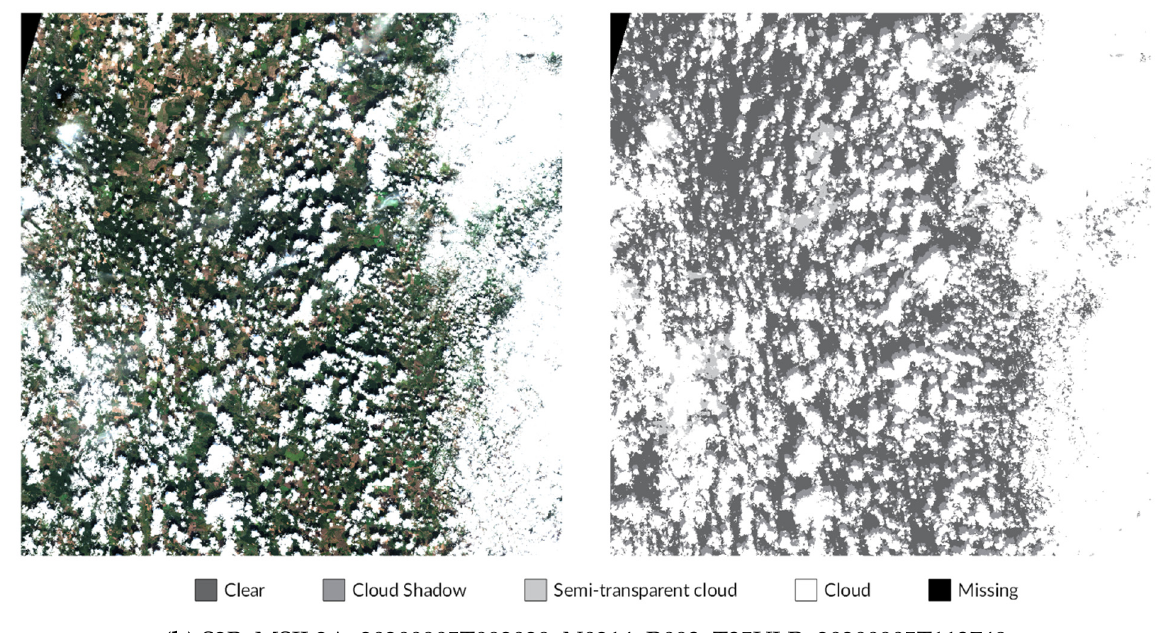
Figure A3. The complete Sentinel-2 L2A product S2B_MSIL2A_20200905T092029_N0214_R093_T35ULR_20200905T113748 (left) and its classification map (right) at 10 m resolution.